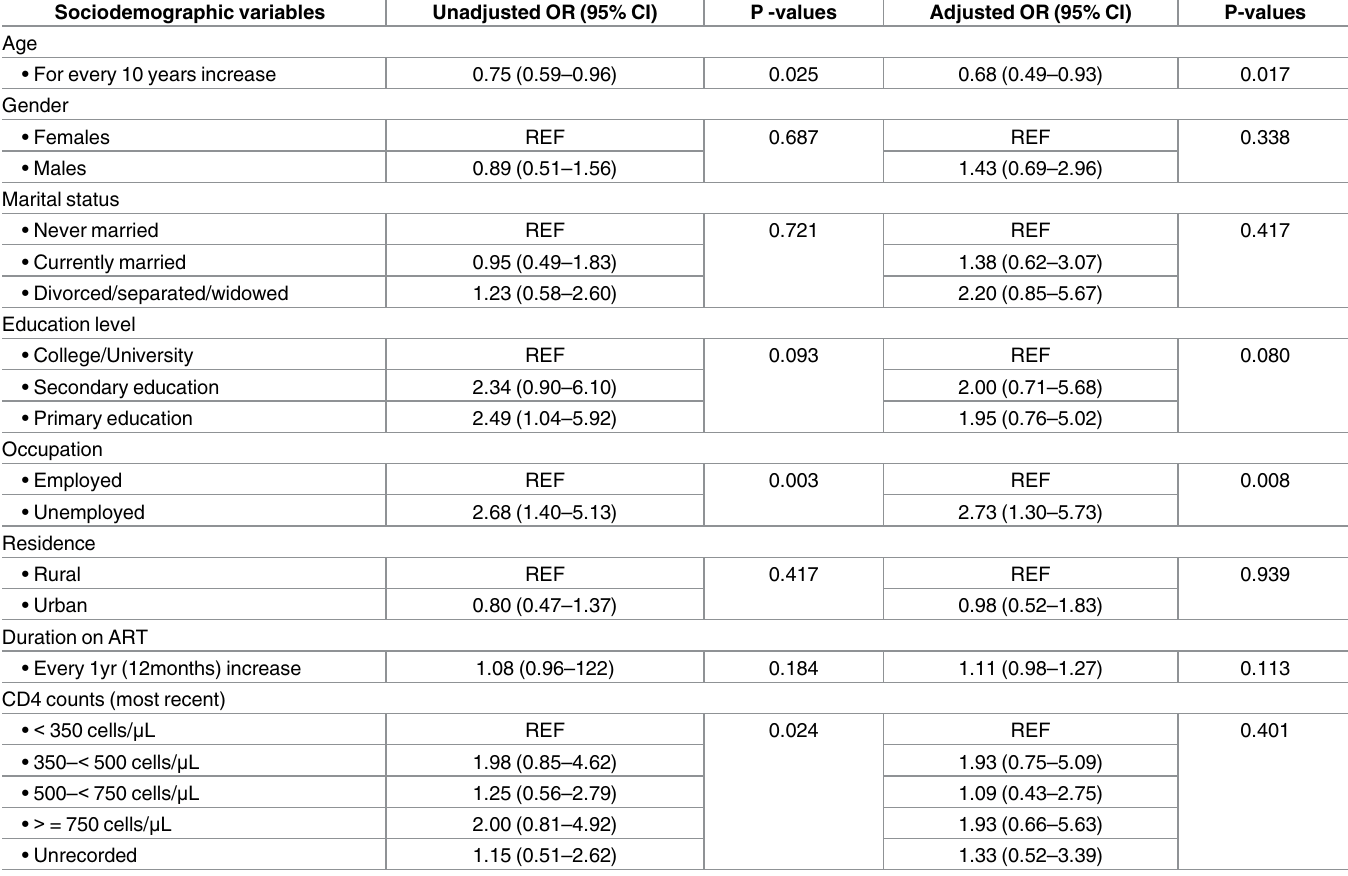
Table 4. Unadjusted and adjusted odds ratios (OR) for predictors of non-adherence to antiretroviral therapy among HIV-infected north Tanzanians (95% adherence